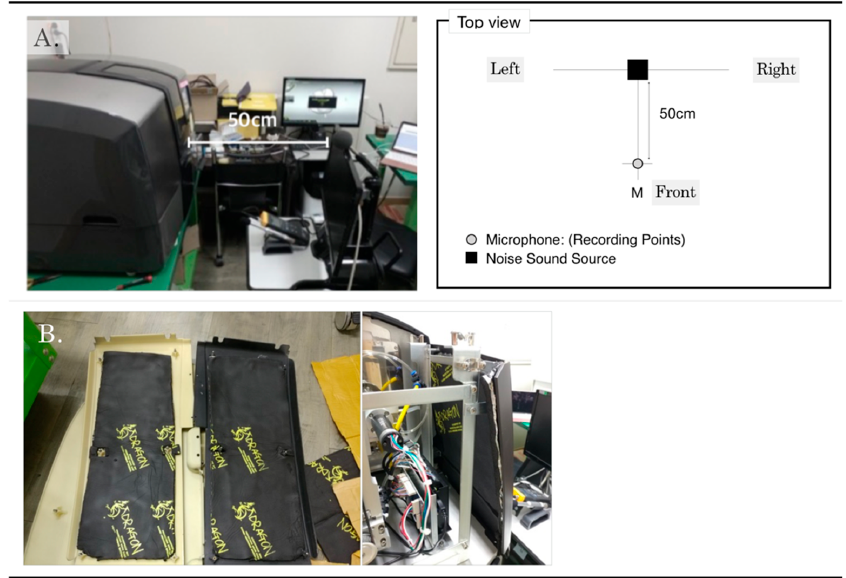
Figure 10. Measuring noise reduction after the application of soundproofing material. ( A ) measurement method; ( B ) the application of soundproofing material to the milling machine housing.